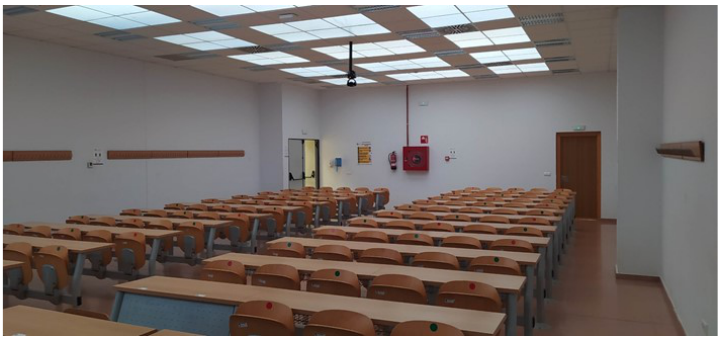
Figure 1. Interior of a classroom in the Leonardo da Vinci building on the Rabanales University Campus of the University of Córdoba (Spain).